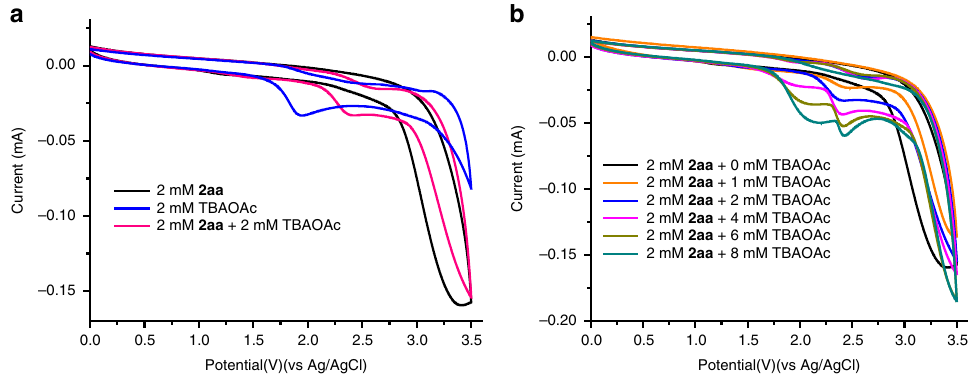
Fig. 8 Cyclic voltammograms studies. a Cyclic voltammograms of dibenzenesulfonimide (2 mM), n Bu 4 NOAc (2 mM), and equivalent mixture of the dibenzenesulfonimide with n Bu 4 NOAc in acetonitrile containing 0.1 M n Bu 4 NBF 4 . b Cyclic voltammograms of dibenzenesulfonimide (2 mM) in acetonitrile containing 0.1 M n Bu 4 NBF 4 and varying concentrations of n Bu 4